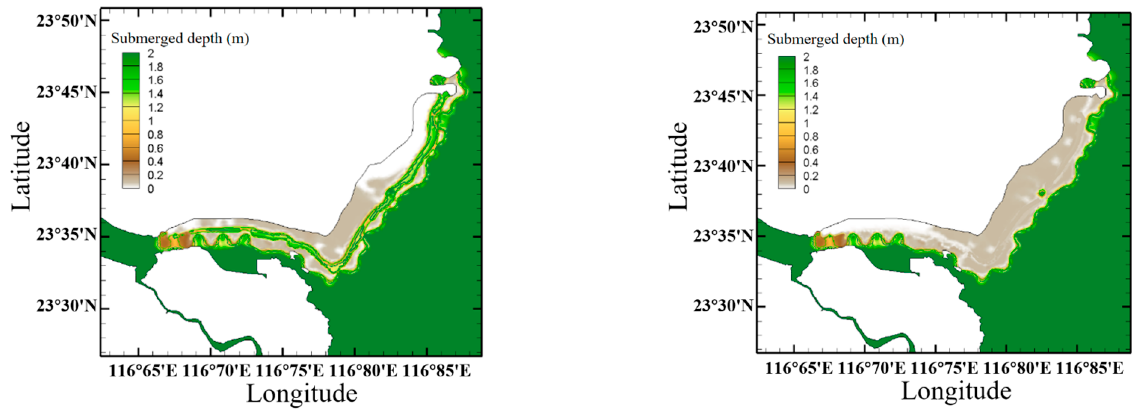
Figure 10. Water accumulation on land after typhoon transit (the left picture shows the existence of bank, and the right picture shows the absence of bank).